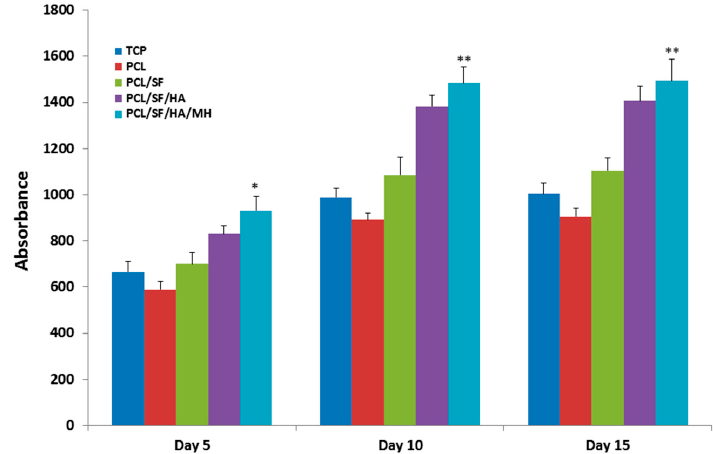
Figure 10. Alkaline phosphatase activity showing the osteogenic differentiation of MSCs on TCP, PCL, PCL/SF, PCL/SF/HA and PCL/SF/HA/MH micro/nanoparticles on day 5, 10 and 15. * p ≤ 0.05, ** p ≤ 0.001.